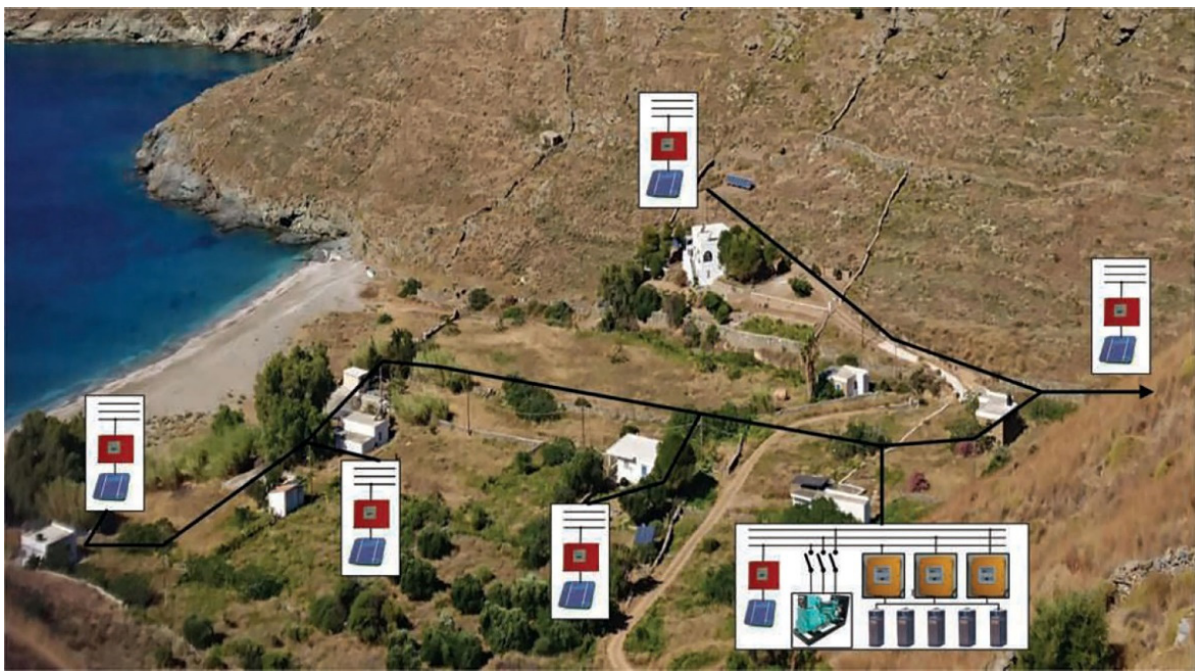
Figure 13. Overview of Gaidouromantra Microgrid in Kythnos island.